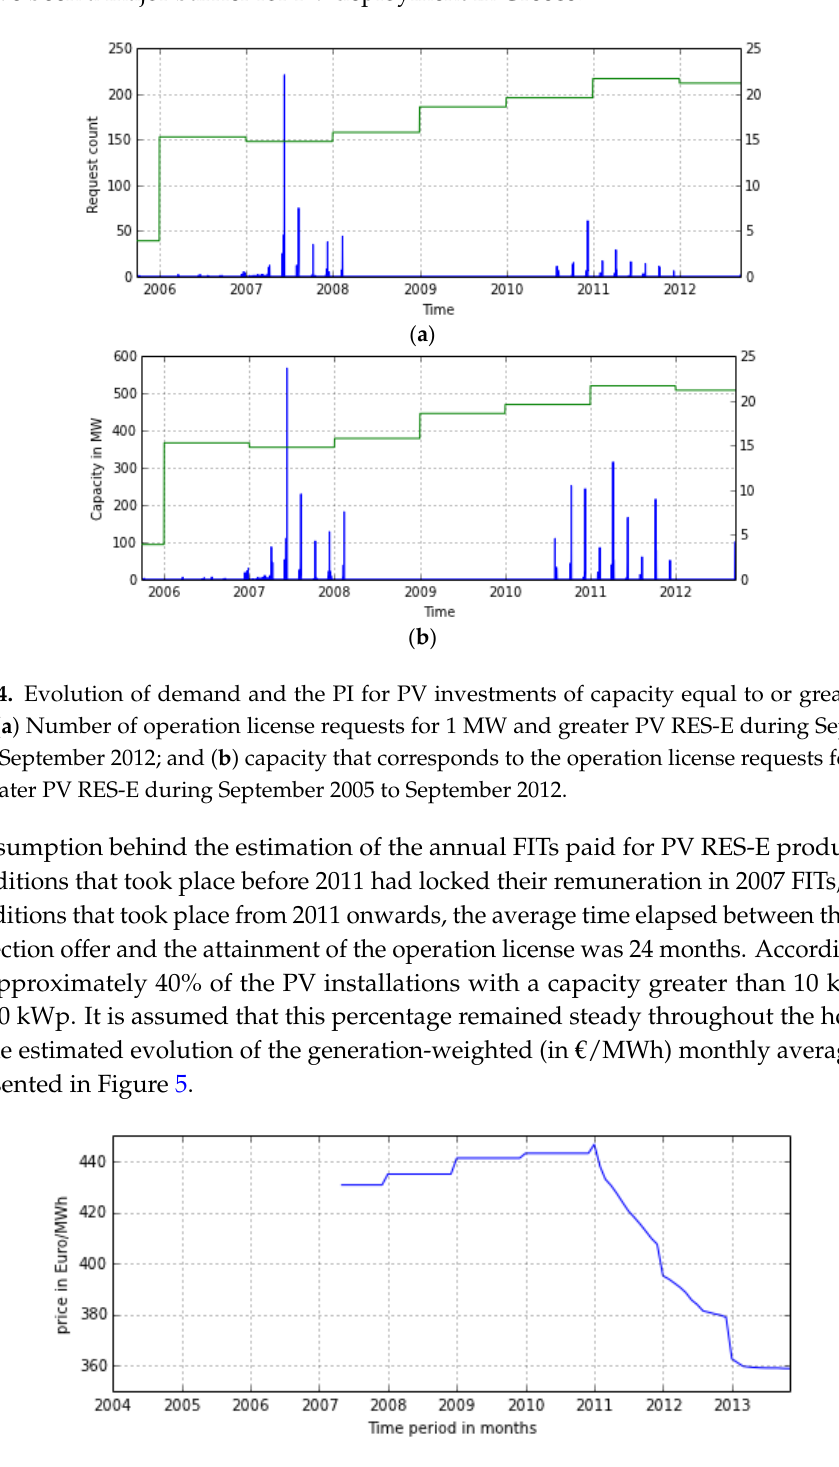
Figure 5. Generation ‐ weighted average PV power price for the period from January 2004 to November 2013.